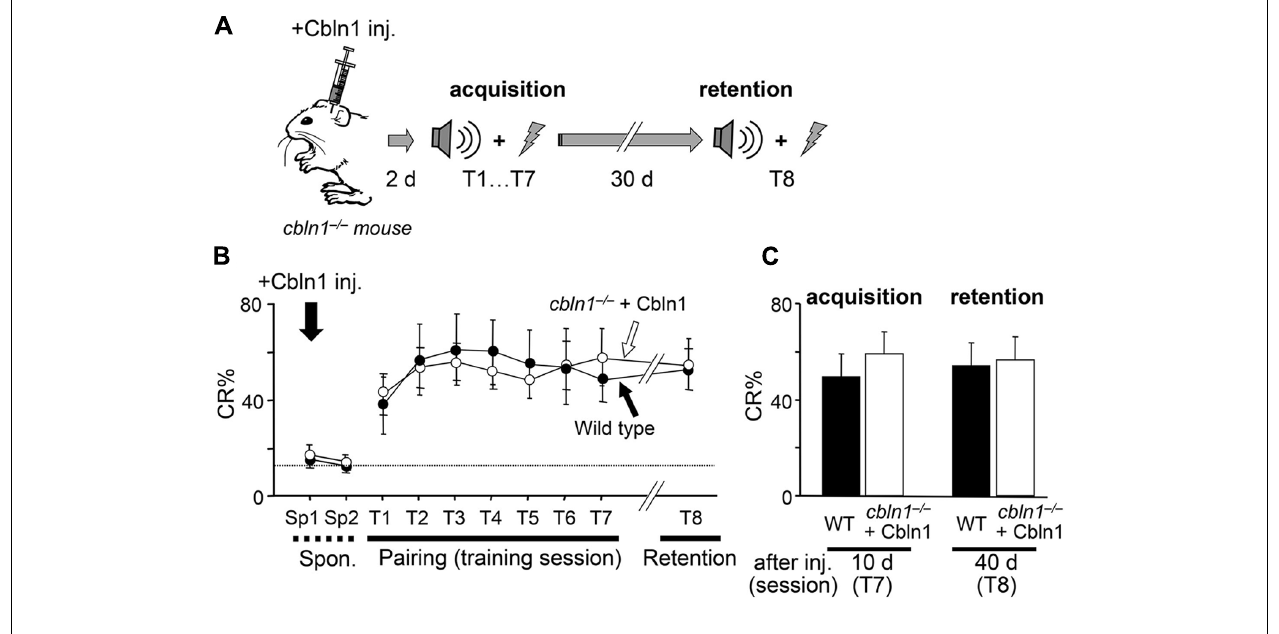
FIGURE 7 | Intact retention and expression of EBC in cbln1 − / − mice. (A) A diagram showing a sequence of experiments: cbln1 − / − mice were injected with Cbln1 as described in Figure 3 and subjected to delay eyeblink conditioning (EBC) from 2 (T1–T7) and at 40 days (T8, 30-days interval between T7 and T8) after the injection to examine the retention of learned responses. (B) Intact retention and expression of EBC in cbln1 − / − mice. During training (T1–T7) and retention (T8) sessions, no difference in